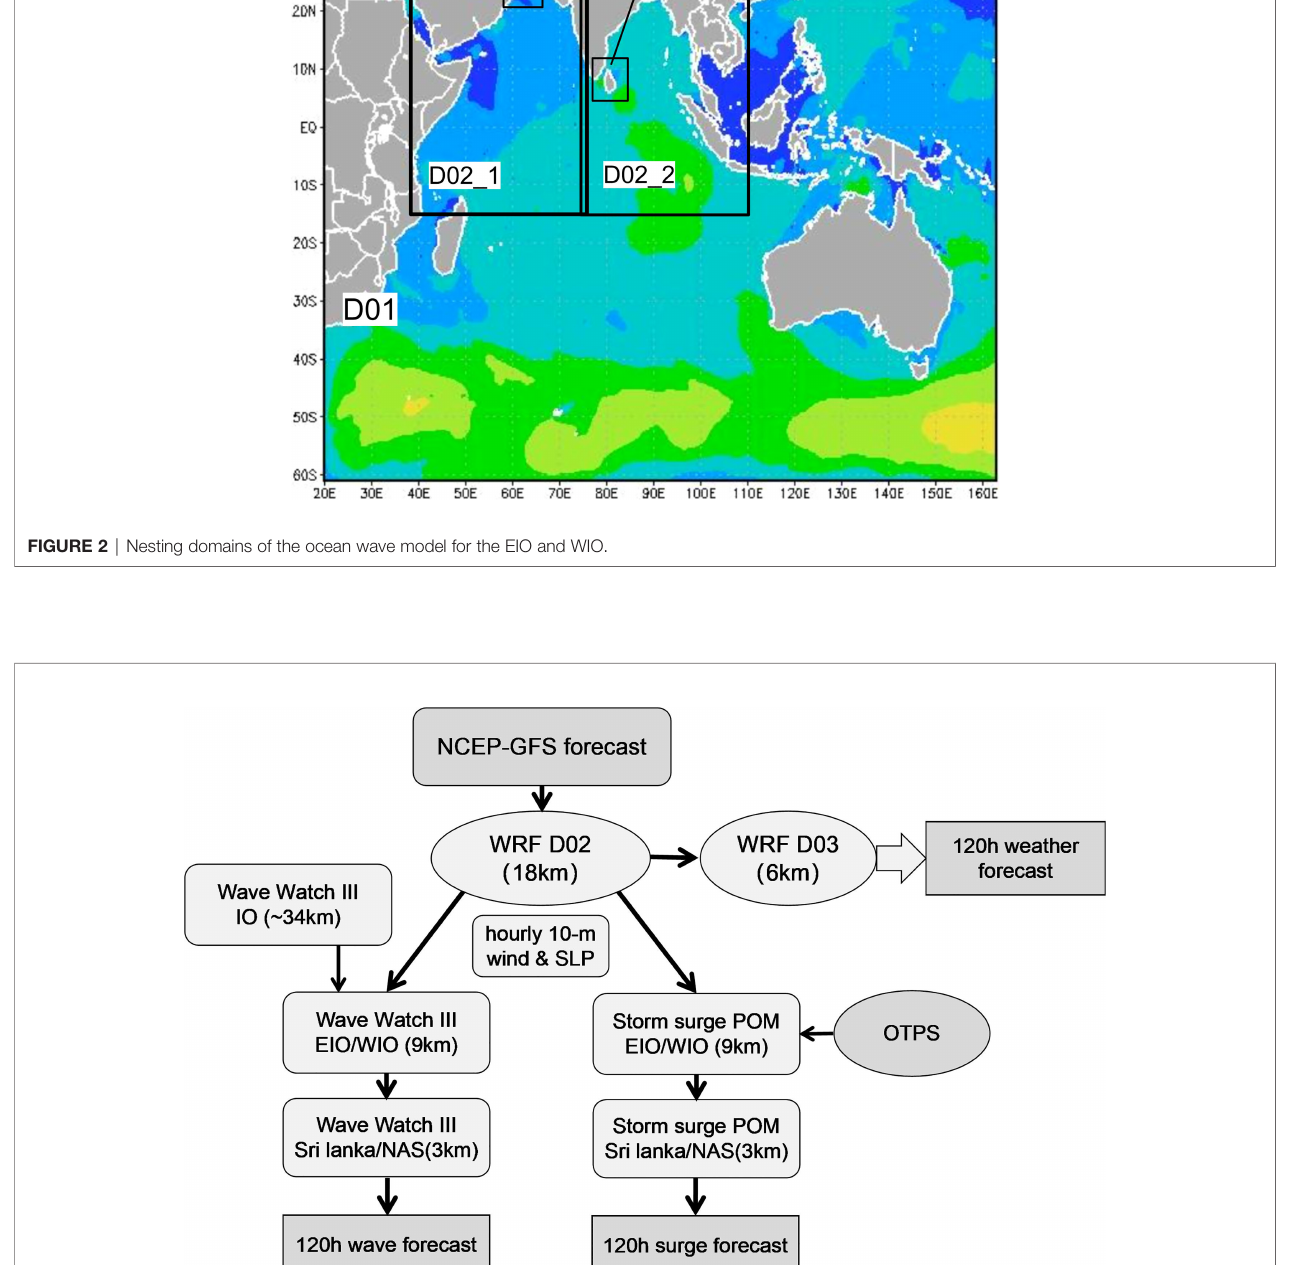
FIGURE 3 | Flowchart of EPMEF-NIO. The National Centers for Environmental Prediction 6-hourly Global Forecast System (NCEP-GFS) from the National Oceanic and Atmospheric Administration (NOAA) and Oregon State University Tidal Prediction Software (OTPS) provide the global atmospheric and tidal information at the boundaries of